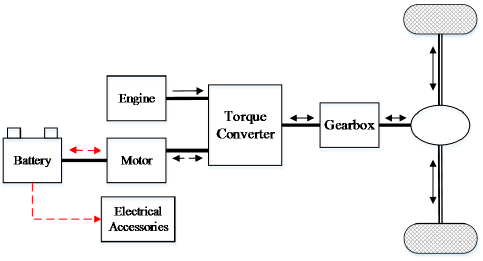
Figure 1. Powertrain structure of a parallel plug-in hybrid electric vehicle.